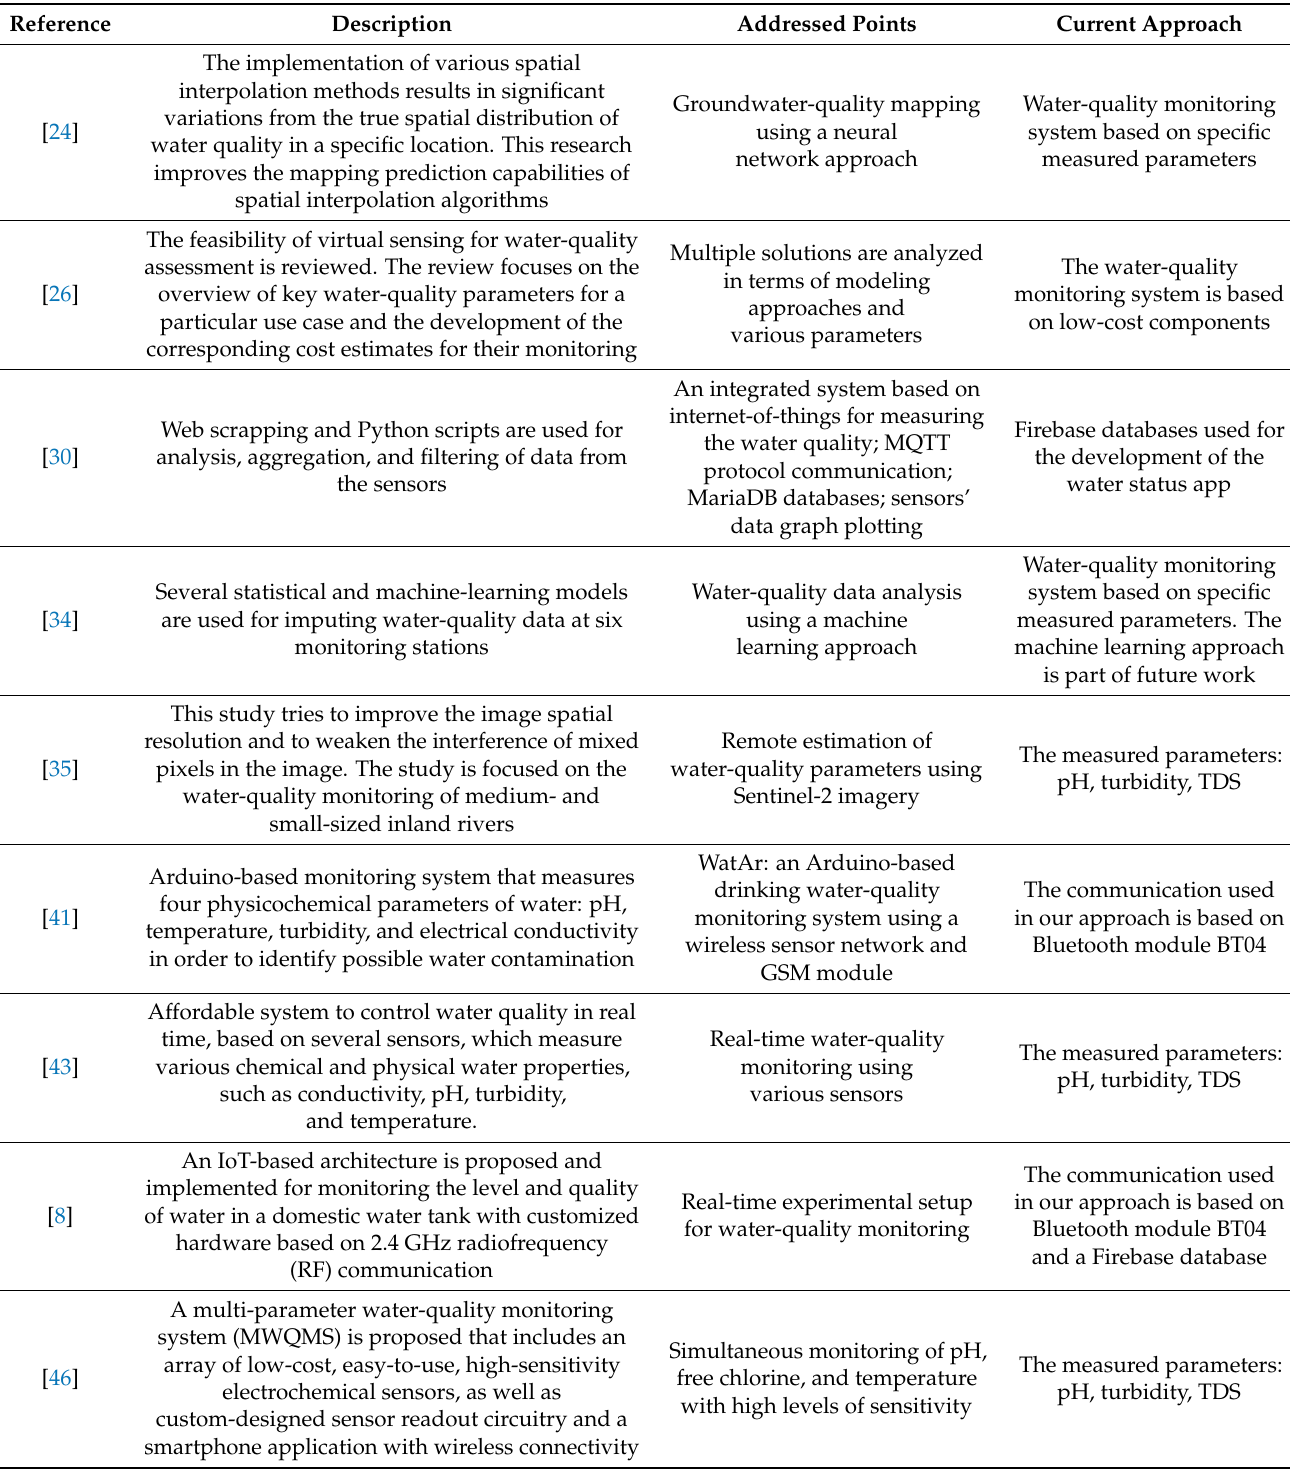
Table 1. Findings of previous studies compared to the current